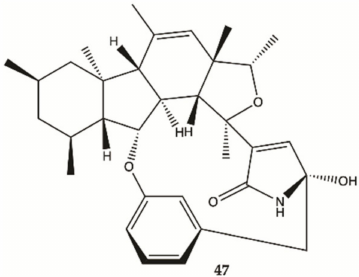
Figure 17. Alkaloid 47 isolated from marine fungus strain ZZ380